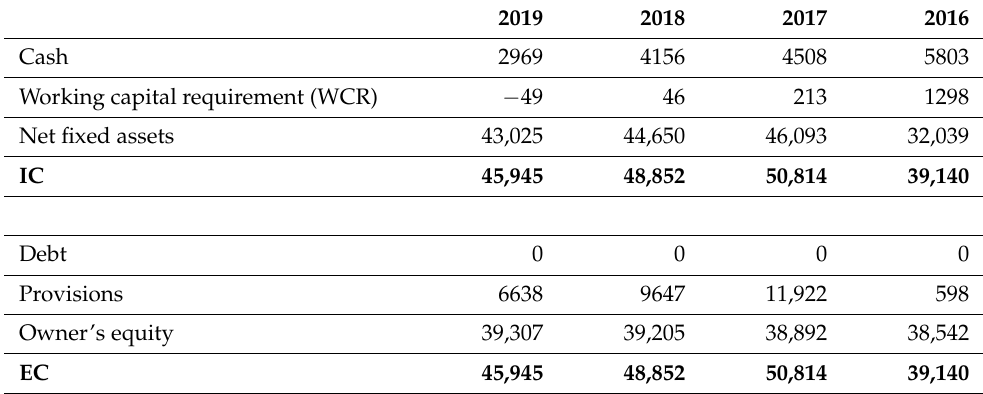
Table 9. Managerial balance sheet of Geotermia Pyrzyce Sp. z o.o (PLN